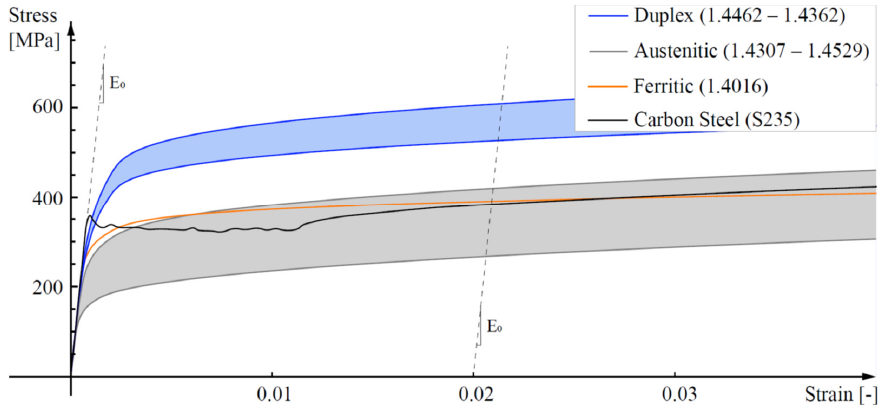
Figure 2. Magnification of steel stress–strain curves shown in Figure 1 at small strains.